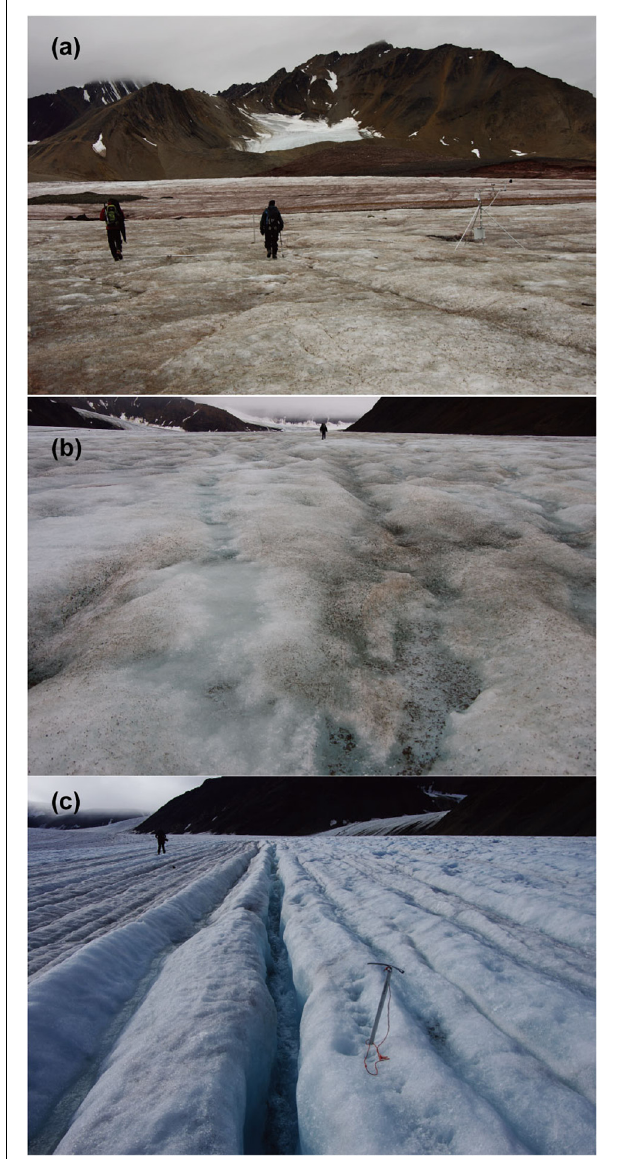
FIGURE 7 | Photographs of typical bare-ice surface on the three glaciers in Svalbard. (a) Austre Brøggerbreen; (b) Midtre Lovénbreen; (c)